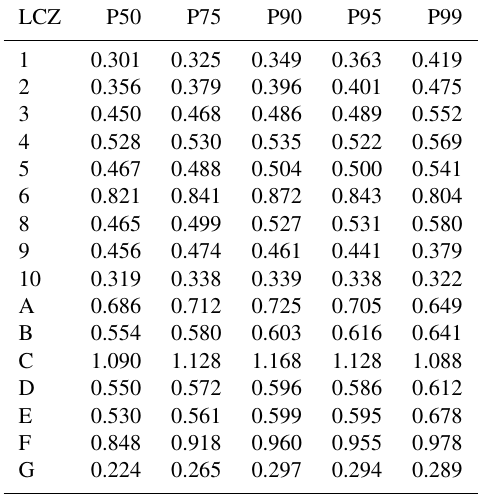
Table 4. Standard deviations for the LCZs for the different per- centiles of